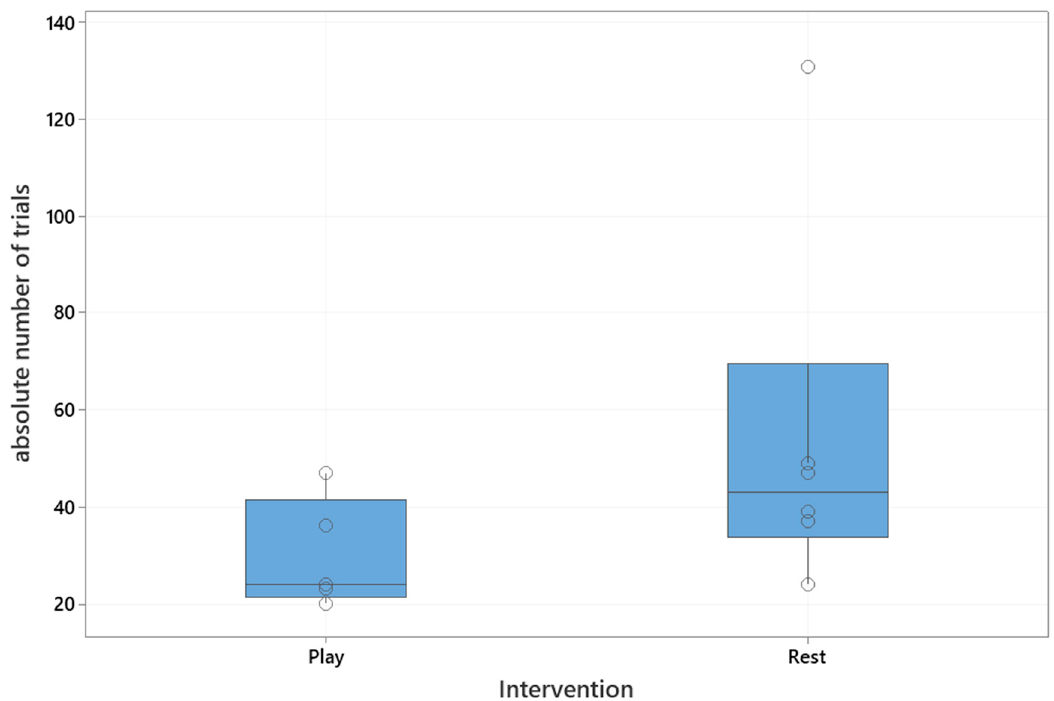
Figure 2. Boxplot of the absolute number of trials needed to reach the training criterion based on intervention. Boxplots show the median and interquartile range from the 25th to 75th interquartile. Open circles represent individual dogs. Play: playful activities group, Rest: resting group.